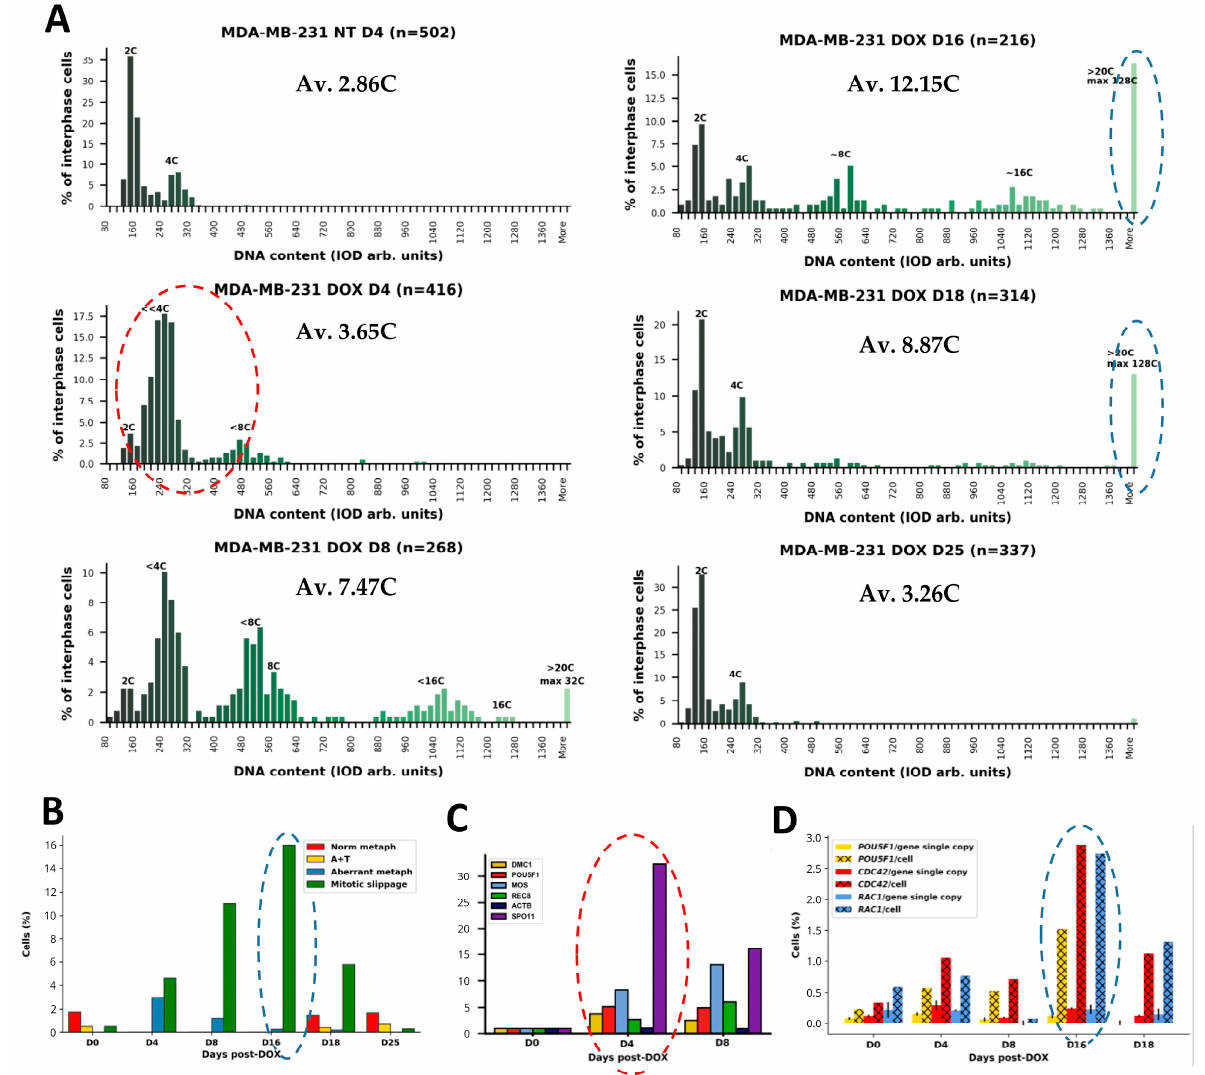
Figure 1. Quantified parameters of MDA-MB-231 cells following DOX treatment: ( A ) Cell cycle changes monitored with in situ DNA cytometry after DOX treatment in a representative experiment; the average ploidy content per cell (AV) is shown for each day. ( B ) Representative differential mitotic counts showing the absence of cell division at the period of increasing MS (D4-D16). ( C ) RT-qPCR results of meiotic gene transcription after DOX treatment, shown as fold change. Representative charts of two independent experiments, with three technical replicates. ( D ) Results of gene transcription evaluation obtained by Selfie digital PCR for three gene transcripts quantified per gene copy and per cell (as transcripts per gene copy multiplied by the average ploidy in the same experiment)—the average of three technical replicates with SEM. Red-dashed circle (in A ) highlights the period of S-G2-M-delay with DNA under-replication in the late S-phase starting the MS, polyploidisation, and the expression of meiotic genes (in C ); blue-dashed circles outline the diverged subpopulation of super-giant cells (in A ) with the highest proportion of MS (in B ) and the highest proportion of the POU5F1 , CDC42 , RAC1 gene expression per cell (in D ) (republished from [4] with an open access CC BY 4.0 license).